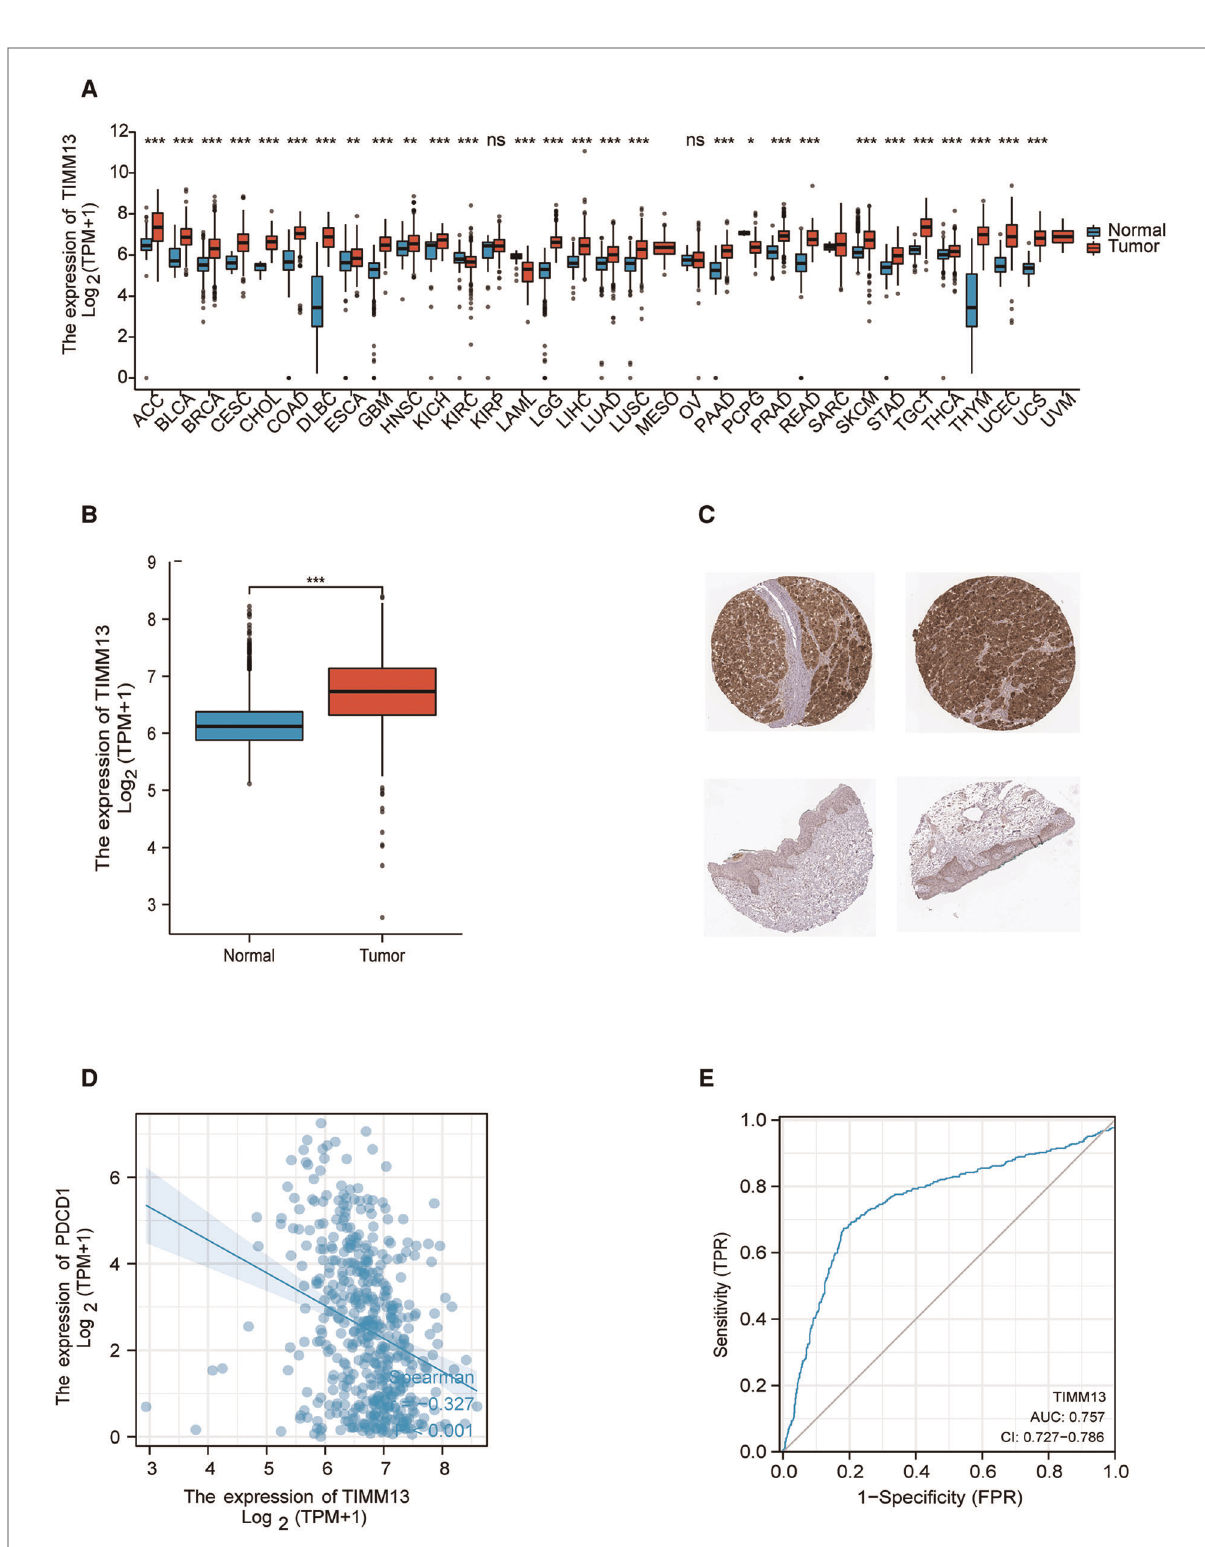
FIGURE 1 TIMM13 expression levels. ( A ) Increased or decreased TIMM13 in different tumor types from The Cancer Genome Atlas (TCGA) database were determined by Xiantao tool (* p <0.05, ** p <0.01, *** p <0.001). ( B ) Increased TIMM13 in SKCM tissues compared with normal tissues. ( C ) TIMM13 immunohistochemical staining levels in SKCM tissues (up) and normal tissues (down) by using HPA database. ( D ) The correlation analysis between TIMM13 and PD1 mRNA level. ( E ) The receiver-operating characteristic (ROC) curve analysis of TIMM13 in SKCM